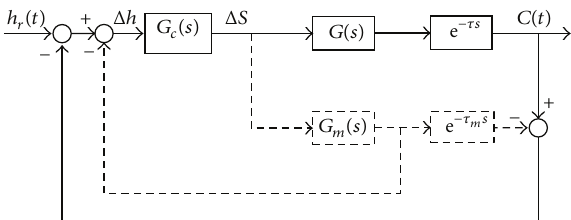
Figure 3: AGC control process based on Smith